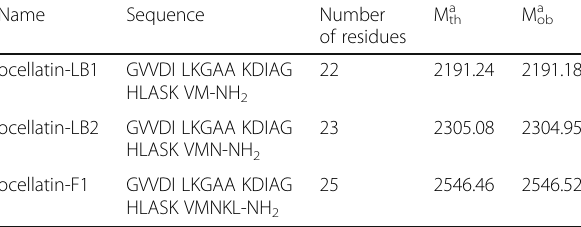
Table 1 Primary structures of three ocellatins determined by Edman